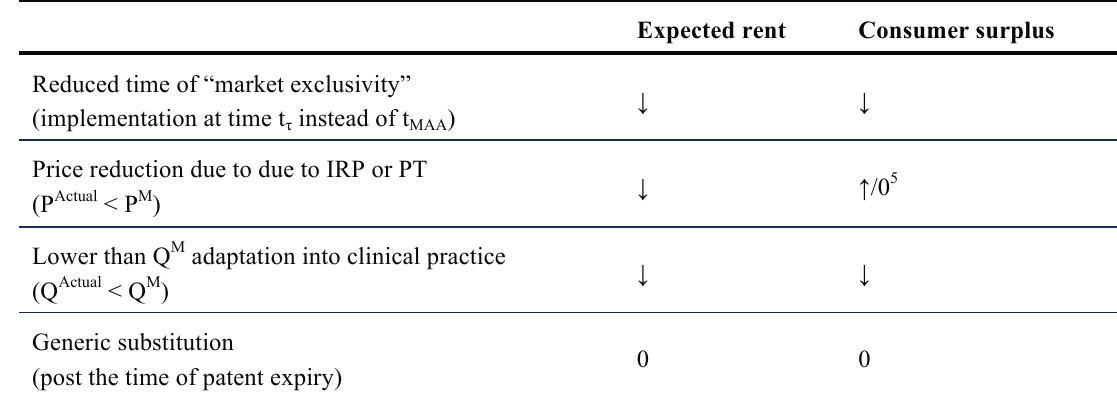
Note: The arrows in the table demonstrate the expected rent and consumer surplus impact of the demand side policies that is analysed in section 3.1-3.4; where ↑ , ↓ and 0 indicate an increase, decrease and